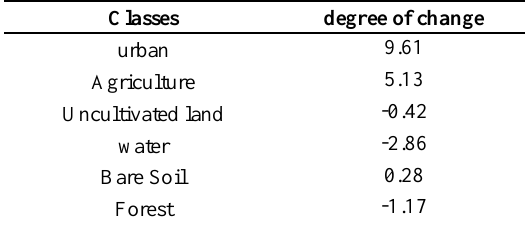
Table 6. The change dynamic